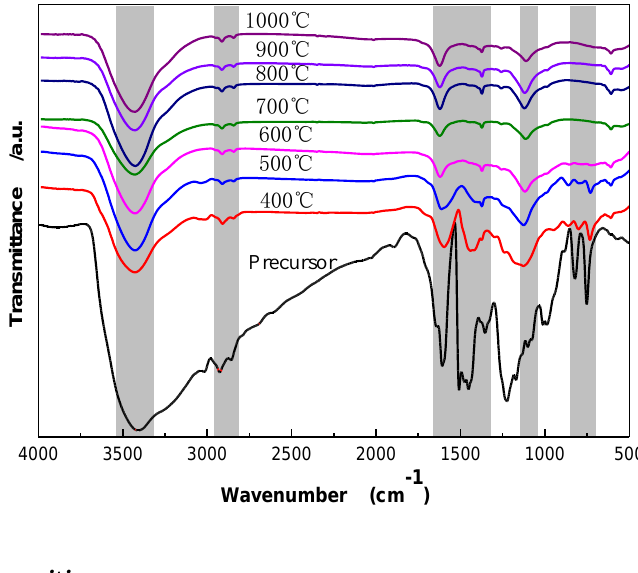
Figure 3. FTIR spectra of CBCFs at various